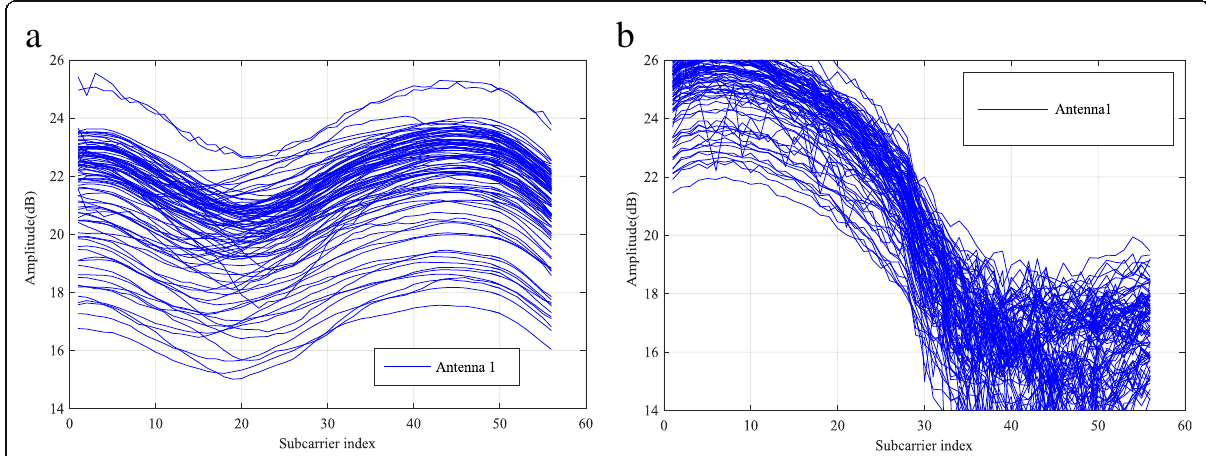
Fig. 3 Fluctuations of CSI amplitudes under different sensitivities. a Amplitude changes in the open hall. b Amplitude changes in the